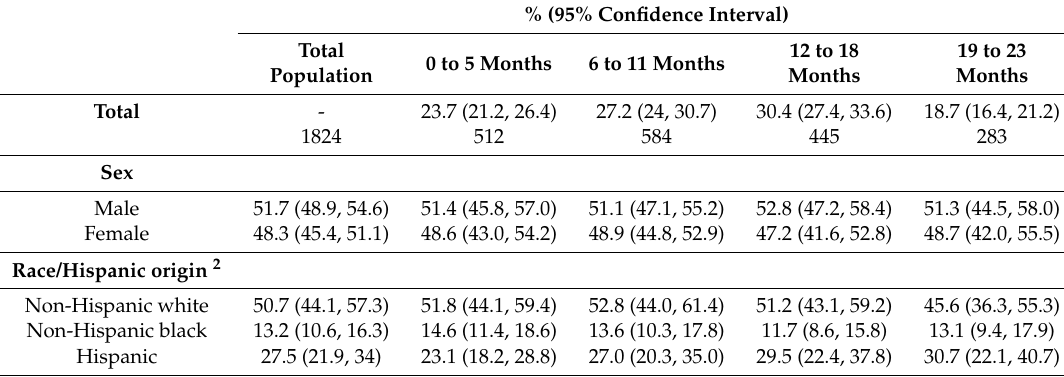
Table 1. Demographic characteristics of U.S. children birth to 23 months of age 1 , NHANES